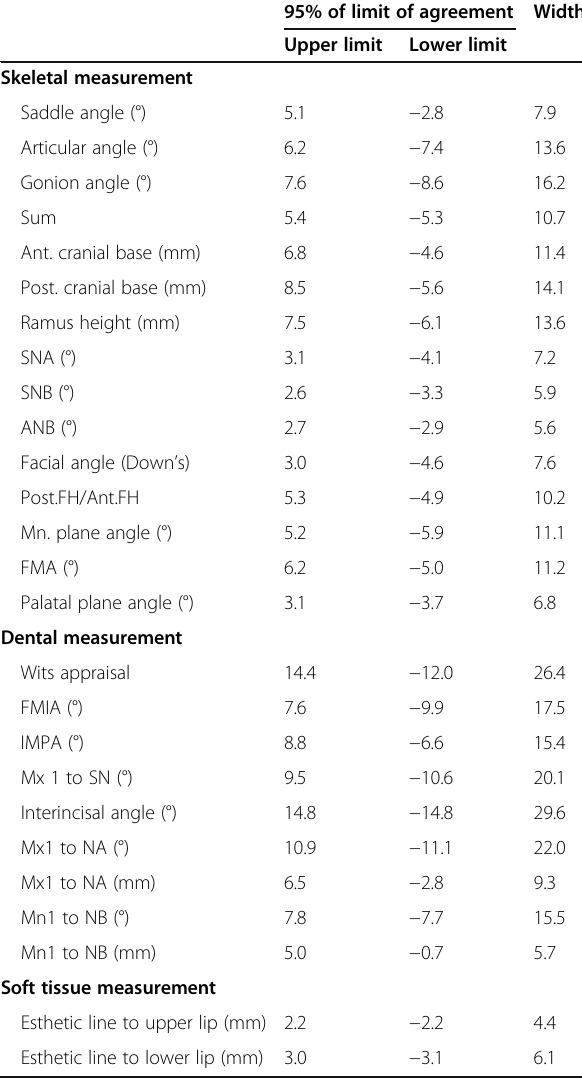
Table 3 Bland-Altman analysis for the cephalometric measurements between conventional and artificial intelligence